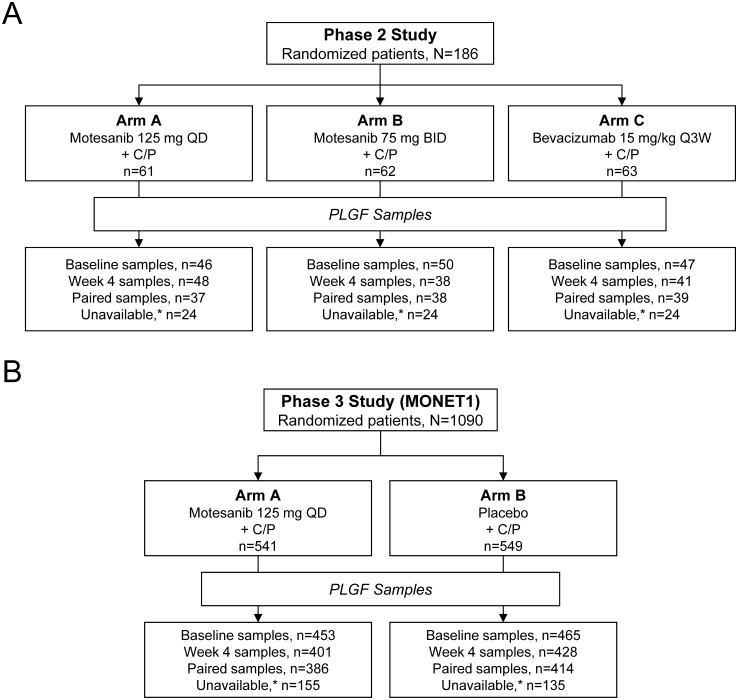
CONSORT diagram.Disposition of patients and availability of PLGF samples from patients enrolled in (A) the phase 2 study and (B) the phase 3 MOtesanib NSCLC Efficacy and Tolerability (MONET1) study of motesanib in non–small-cell lung cancer are shown. BID = twice daily; C/P = carboplatin and paclitaxel; QD = once daily; Q3W = every 3 weeks. *Patients without paired PLGF samples.